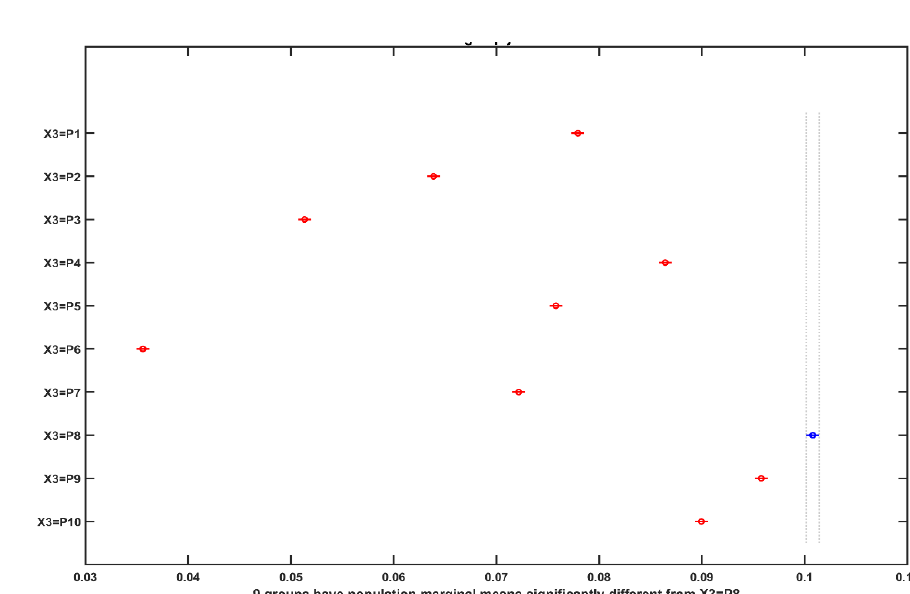
Figure 7. ( a ) ANOVA table: Three-way ANOVA for the factors of interest – montages (X1), brain regions (X2), subject (X3), and their interactions – all found significant. ( b) Results of the multiple comparison test of the population marginal means between the PO9h – PO10h montage and the Exx7 – Exx8 montage (X1). ( c ) Results of the multiple comparison test of the population marginal means of different brain regions (X2). The dentate nuclei were exposed to the highest electric field strength (>0.12 V/m) across montages (X1) and subjects (X3). ( d ) Results of the multiple comparison test of the population marginal means of different subjects (X3). Subject P8 was exposed to the highest electric field strength (>0.1 V/m) across montages (X1) and brain regions (X2). Source: Source of variability;.Sum Sq.: Sum of Squares due to each source; d. f.: Degrees of freedom associated with each source; Mean Sq.: Mean Square for each source, which is the ratio Sum Sq. /d. f. F: statistics which is the ratio of the mean squares.